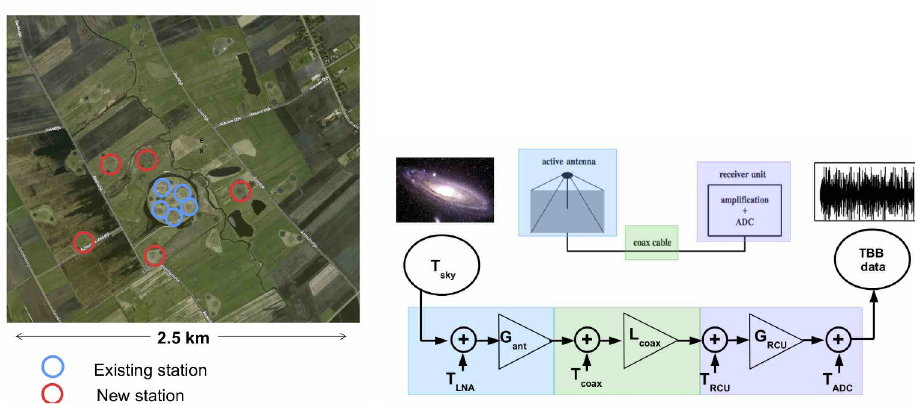
Figure 2. Left: Satellite image of the LOFAR dense core, illustrating the extension of the scintillator array. Blue circles indicate existing stations with particle detectors. In addition, particle detectors will be installed at the stations indicated with red circles. Right: LOFAR signal chain, illustrating the various steps from the observed signal on the sky to recorded ADC values, stored in ring bu ff ers (transient bu ff er boards – TBB)